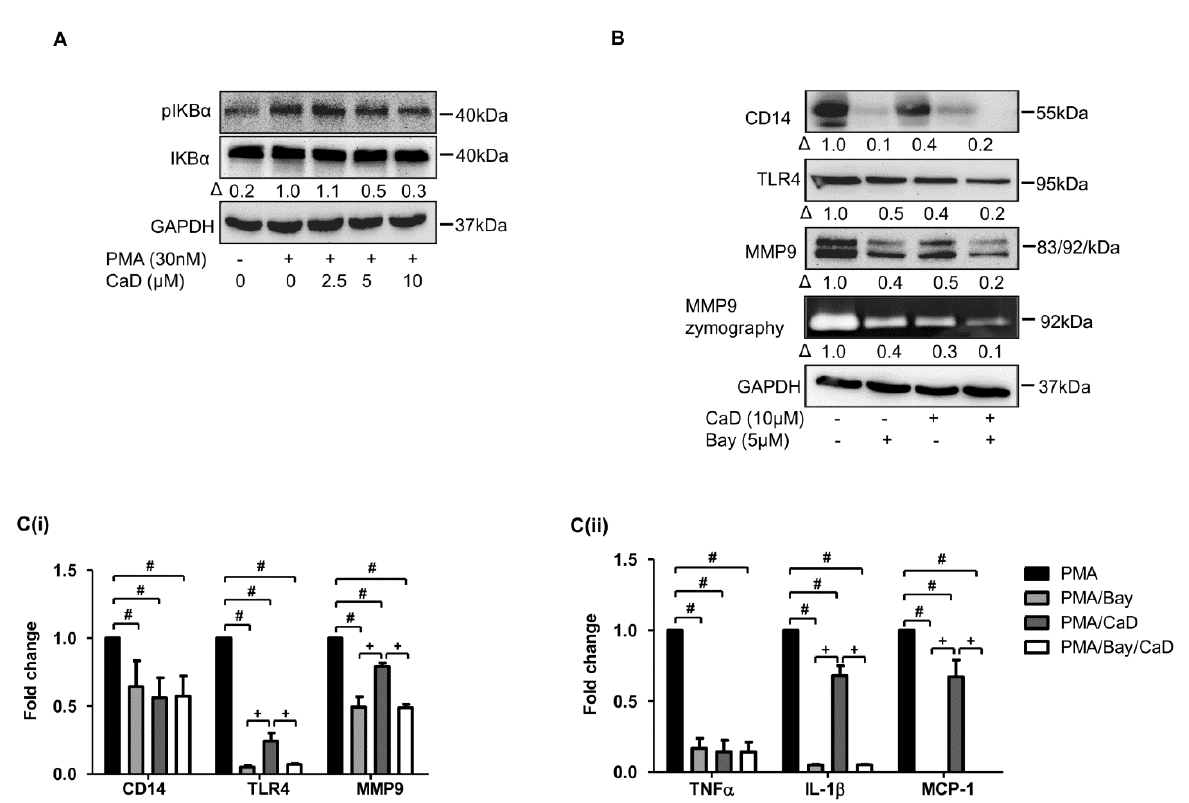
Figure 8. CaD inhibits monocyte-to-macrophage differentiation and inflammation in an NF- κ B-dependent manner. THP-1 monocytes were pretreated with various concentrations (0–10 µ mol/L) of CaD for 1 h, followed by PMA treatment for 10 min ( A ). THP-1 monocytes were pretreated with an NF- κ B inhibitor (Bay 11-7085) for 1 h, followed by CaD for 1 h, and then treated with PMA (30 nmol/L) for 72 h ( B , C ). IKB α phosphorylation and the differentiation and inflammation marker expression ( A , B ) were measured by Western blotting, MMP9 activity was measured by gelatin zymography, and transcript ( C ) levels were measured by quantitative RT-PCR. ∆ , fold change normalized to PMA only ( n = 3, mean ± SEM. + p < 0.05 vs. Bay treatment, # p < 0.05 vs. PMA only, one-way ANOVA). The Western blots represent one from at least three independent experiments.